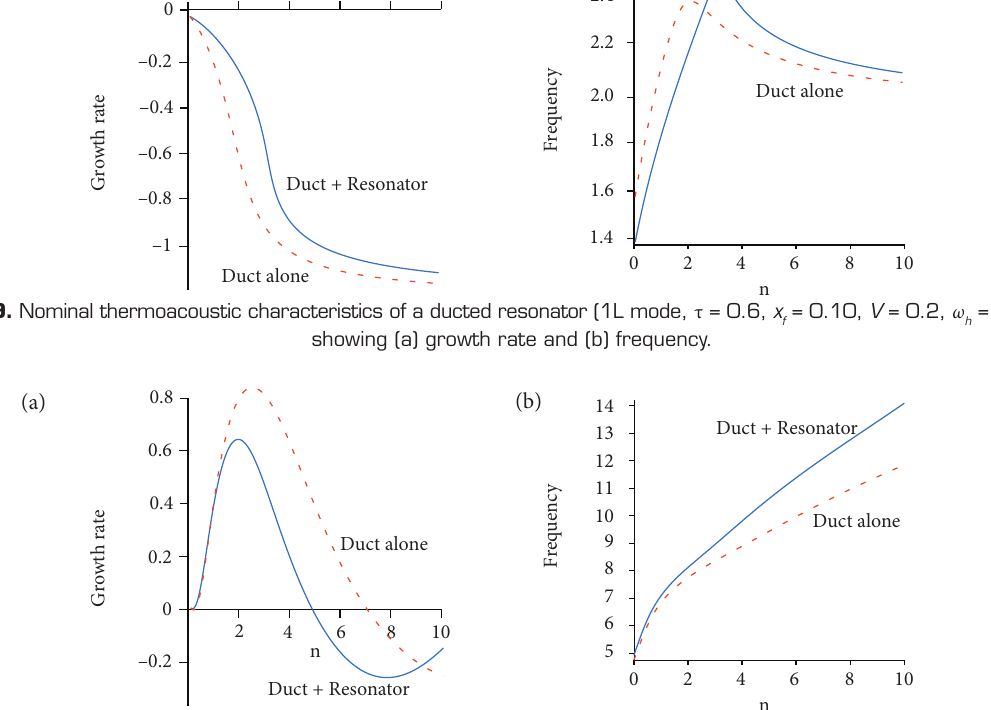
Figure 10. Nominal thermoacoustic characteristics of a ducted resonator (3L mode, τ = 0.6, x